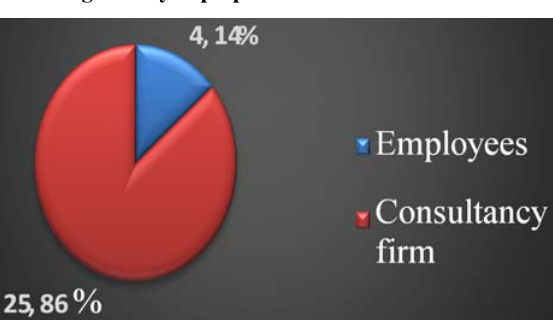
Fig. 1. Do you prepare financial statements?